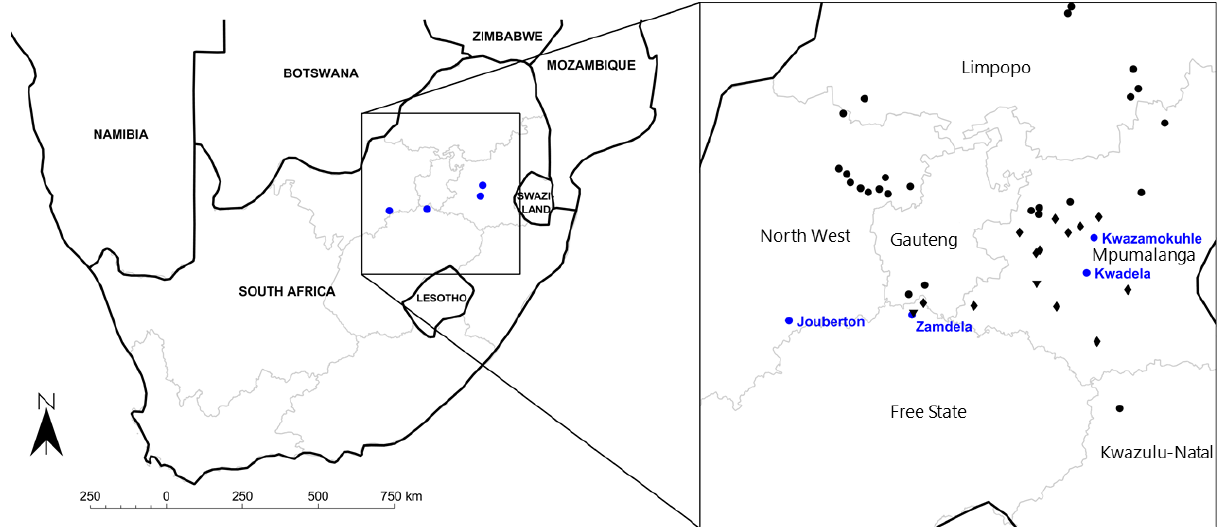
Figure 1. Map of South Africa indicating the location of the four low-income urban settlements and major large point sources within the north-eastern